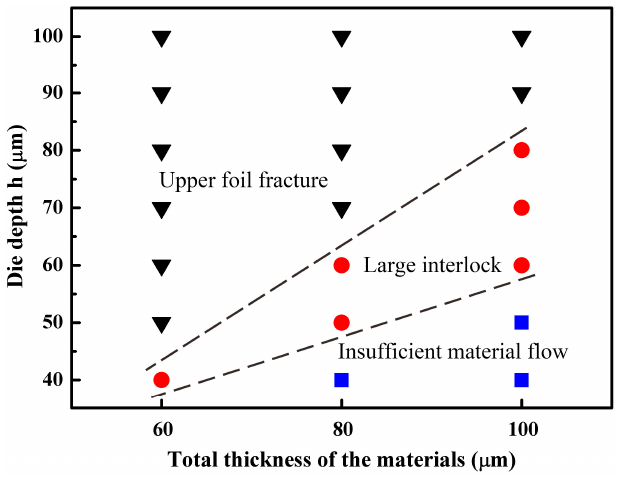
Figure 8. Matching relationship between the total thickness of materials and die depth.